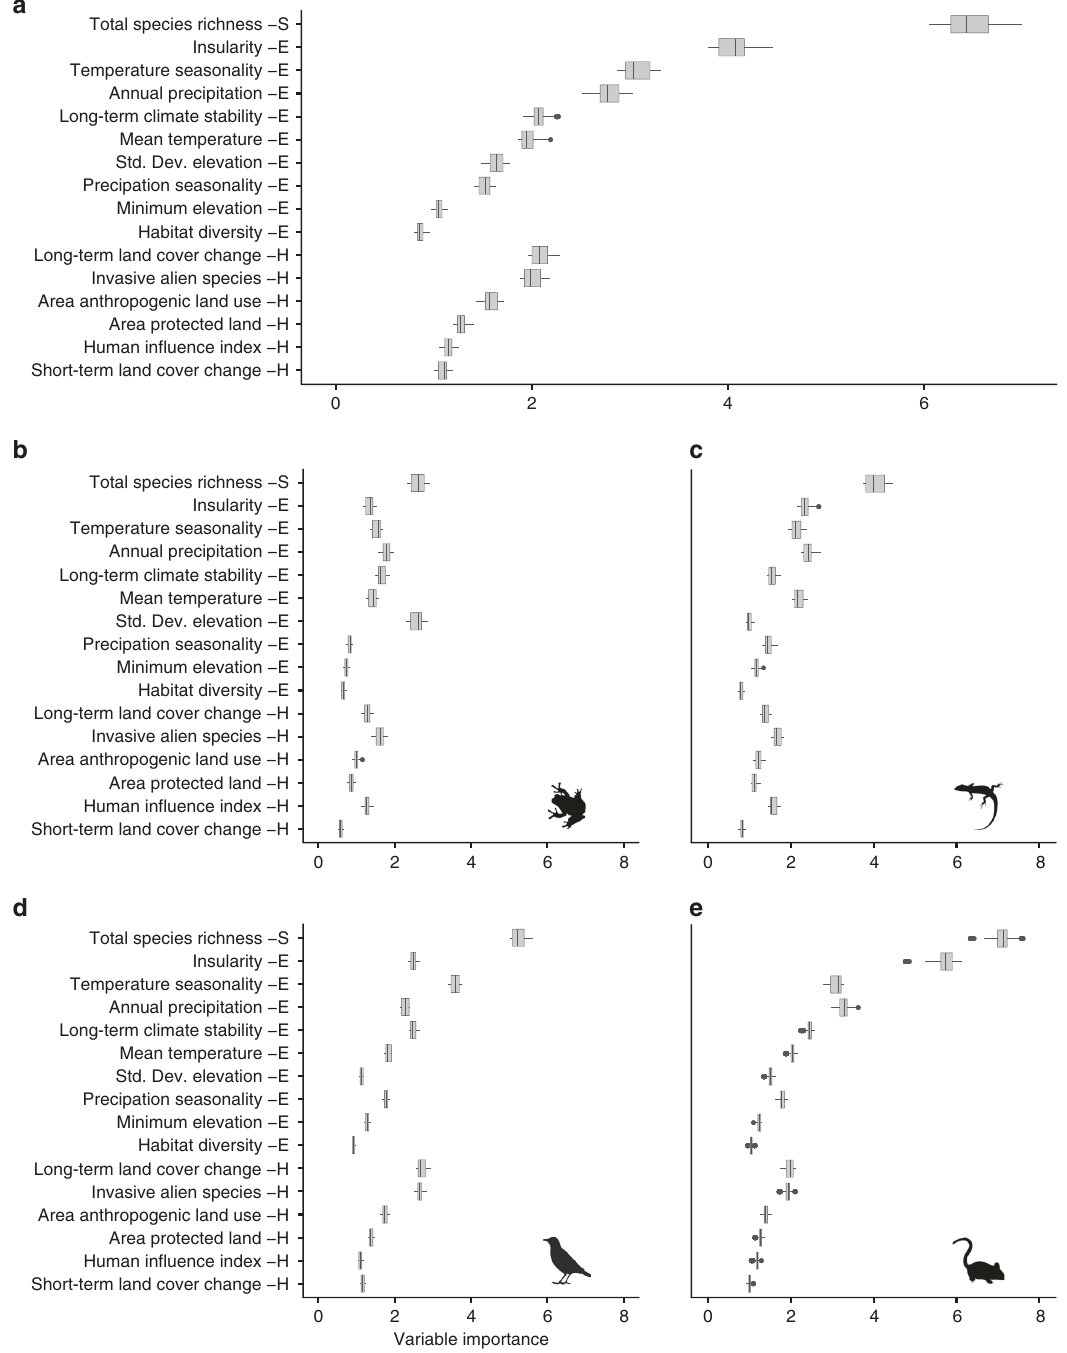
Fig. 2 Importance of individual variables for predicting global threatened species richness. Top panel a indicates the importance of individual variables from the global models of vertebrate threatened species richness, whilst the bottom panels indicate the measures of individual variable importance from the global models of amphibian ( b ), reptile ( c ), bird ( d ) and mammal ( e ) threatened species richness. Variables are grouped into broader classes, which are indicated by the capital letters on the side of the variable names: Total Species Richness (S), Environmental (E), and Human Impact (H) covariates. Variables are ranked fi rst by groups and then by their median importance in the global model of vertebrate threatened species richness. The vertical line across each box indicates the median and the box boundaries indicate the interquartile range (IQR). Whiskers identify extreme data points that are not more than 1.5 times the IQR on both sides; the dots are more extreme outliers. Source data are provided as a Source Data fi